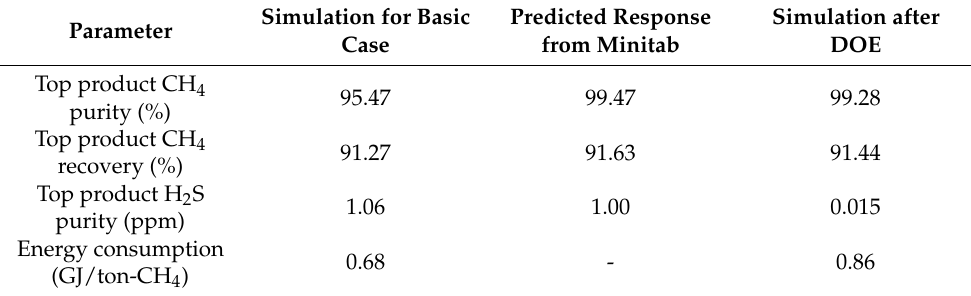
Table 18. The results of simulation before and after the DOE.